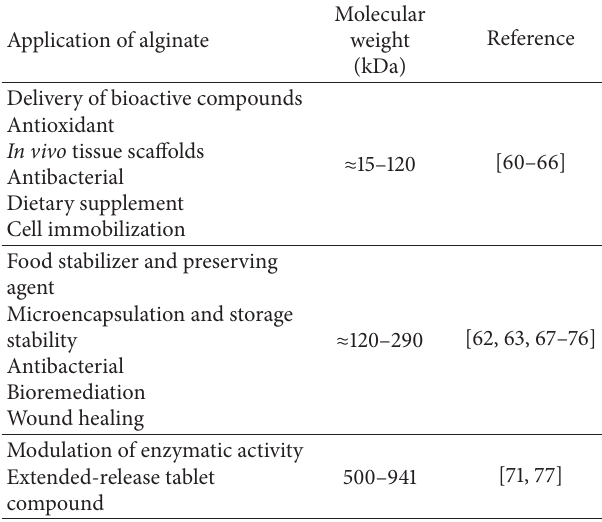
Table 1: Summary of biotechnological and pharmaceutical applica- tions of alginates based on their molecular